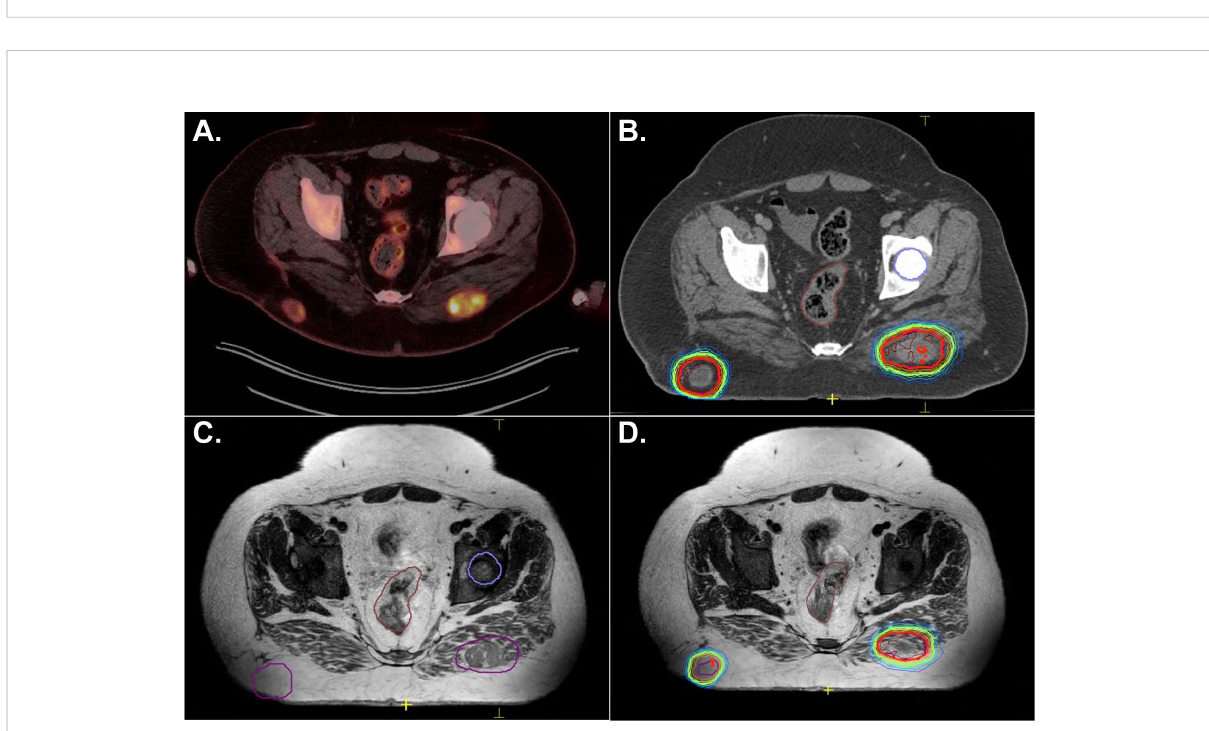
FIGURE 3 A 24-year-old male with metastatic Ewing sarcoma presented with two enlarging, painful gluteal metastases. Panel (A) shows the diagnostic PET scan. Panel (B) shows the lesions on CT. Notably, on both the PET scan and treatment planning scan, both nodules were visualized in the same plane. A single isocenter plan was created. Panel (C) shows the MRI obtained during the fi rst fraction of treatment where the right-sided lesion is now out of the plane. Panel (D) shows successful adapt-to-shape for this single isocenter